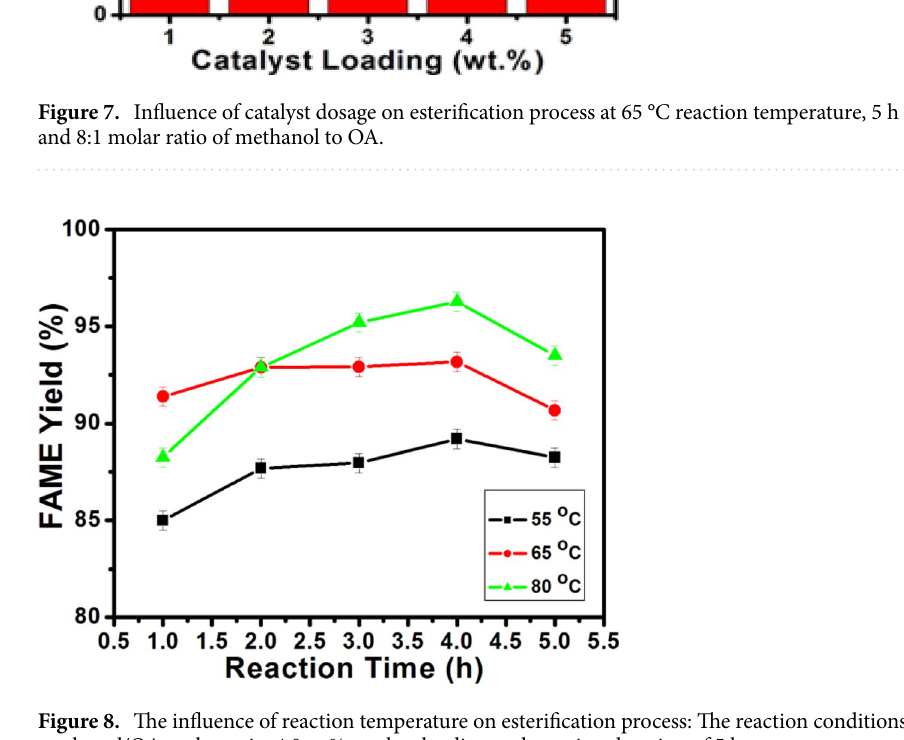
Figure 8. The influence of reaction temperature on esterification process: The reaction conditions: 8:1 methanol/OA molar ratio, 4.0 wt% catalyst loading and reaction duration of 5